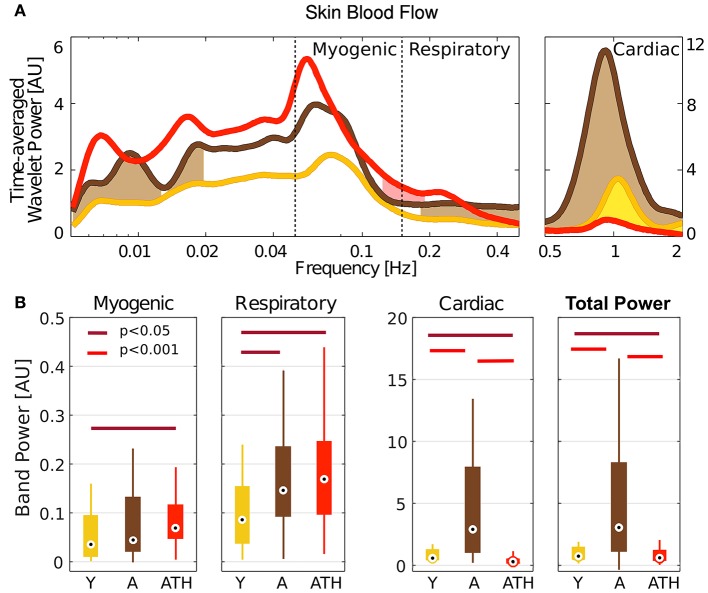
Wavelet power: (A) Time-averaged wavelet power of blood flow, means over groups. Brown shading indicates significance between A and Y, red shading between ATH and A, and yellow shading between Y and ATH. (B) Box-plots showing the cardiac, respiration and myogenic oscillations and the total power in the LDF signal within these three intervals. The Y group is represented in gold, A in brown, and ATH in red.